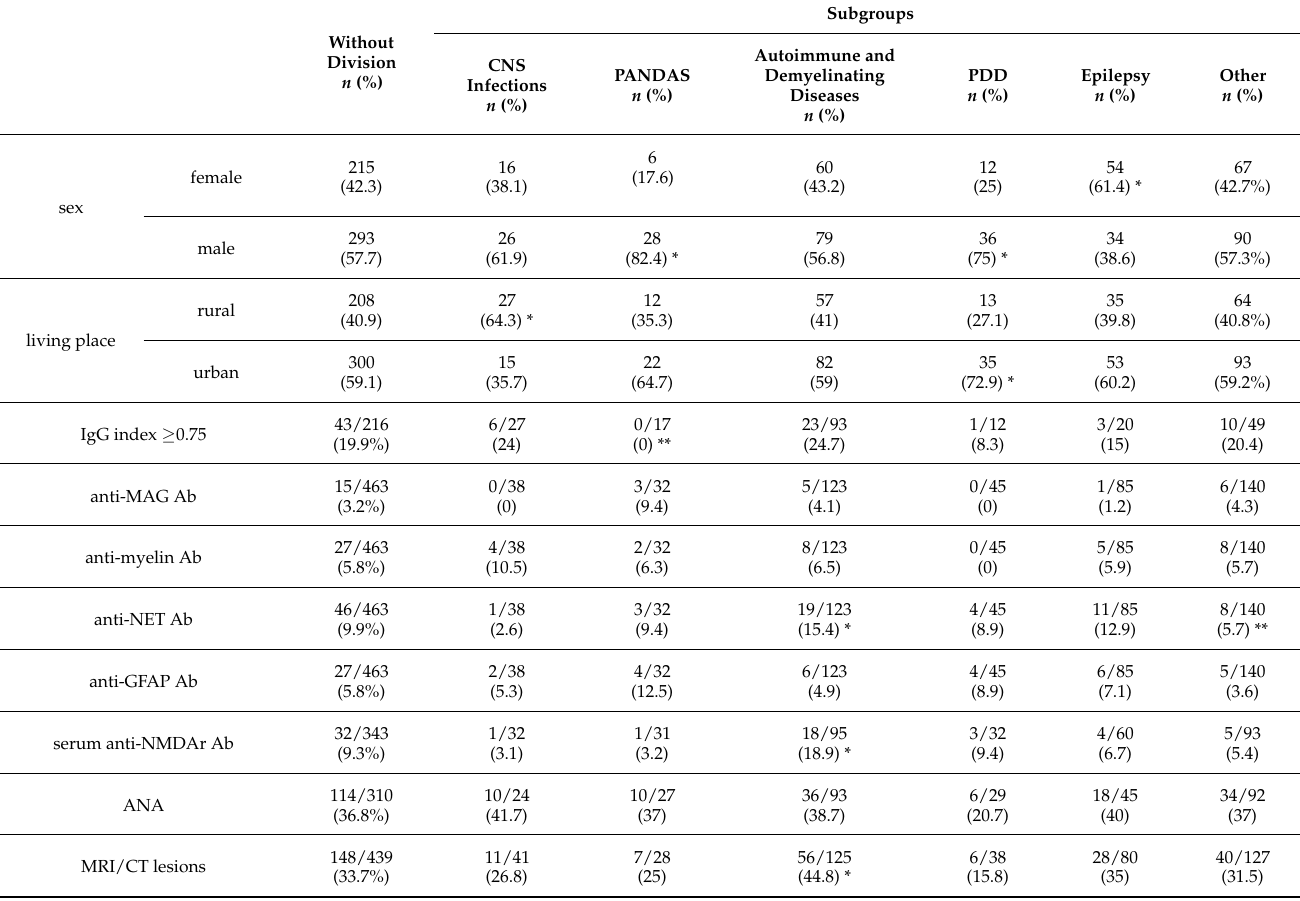
Table 3. Summary of demographic, radiologic and selected autoimmunity